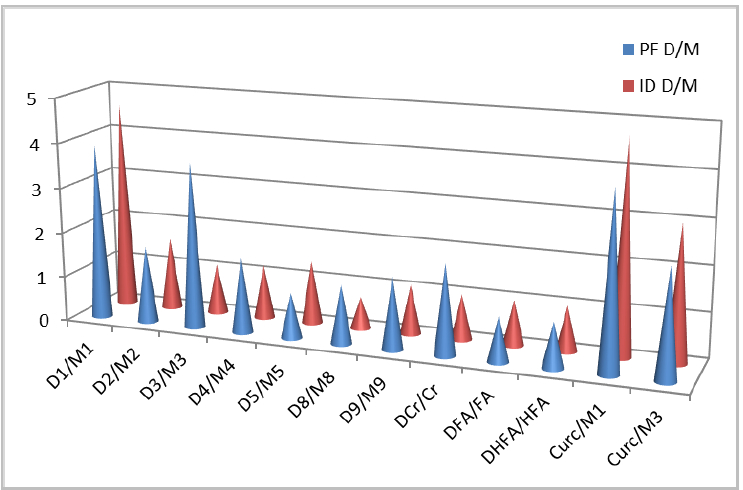
Figure 3. Effect of biphenyl structure. The main kinetic parameters evaluated for dimer/monomer pairs.